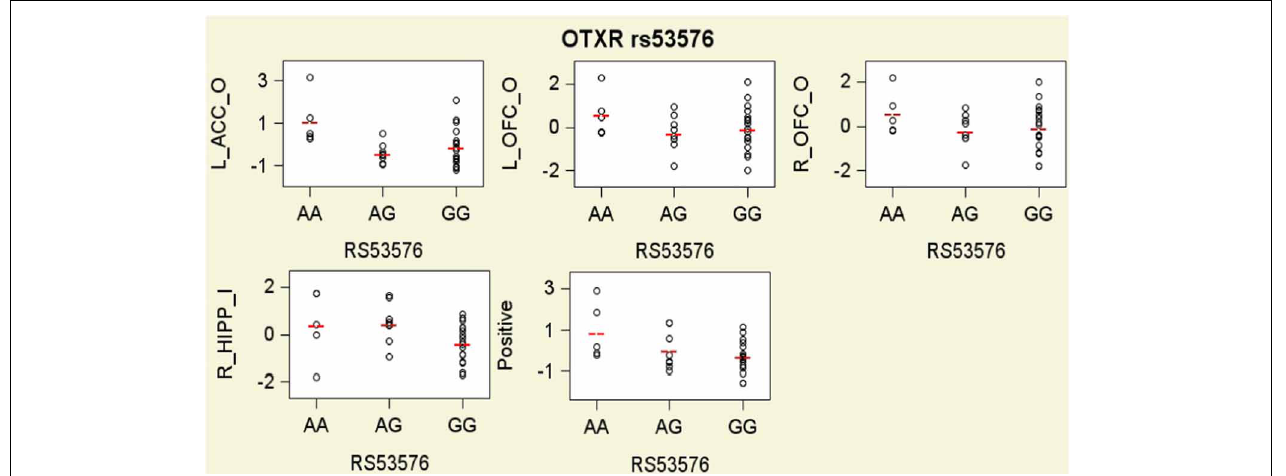
FIGURE 3 | Scatter plots with group means residualized on all covariates for hemodynamic responses in the own/other child (O) contrast and the inappropriate/appropriate behavior contrast (I) in brain regions of interest that were found to be significantly related to oxytocin and